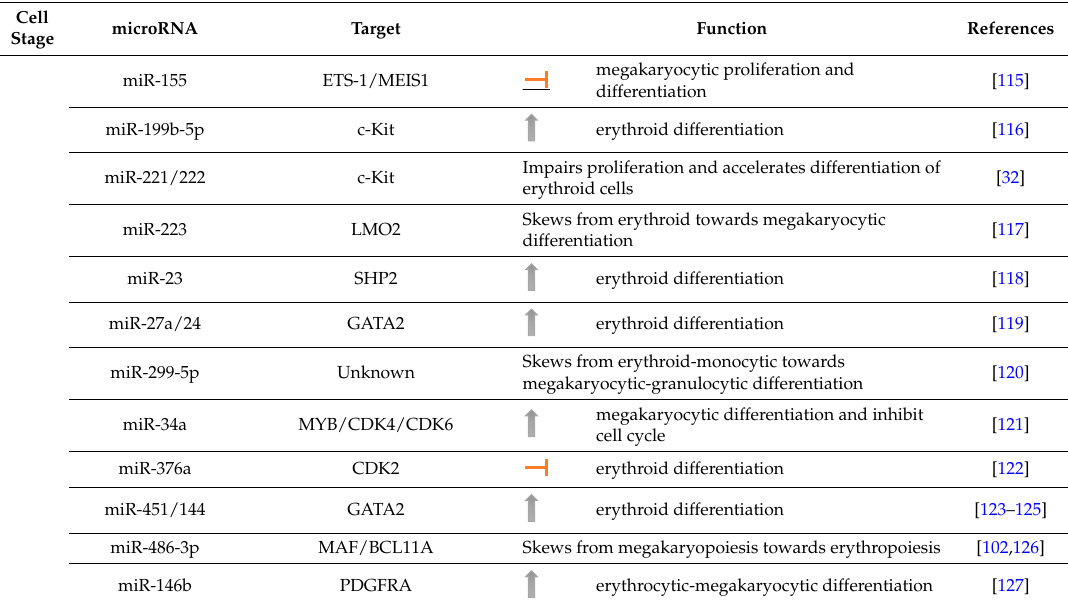
Table 1. miRNAs involved in myelopoiesis which are involved in key (stem) cell processes (differentiation, self-renewal, apoptosis and proliferation) and their identified targets.